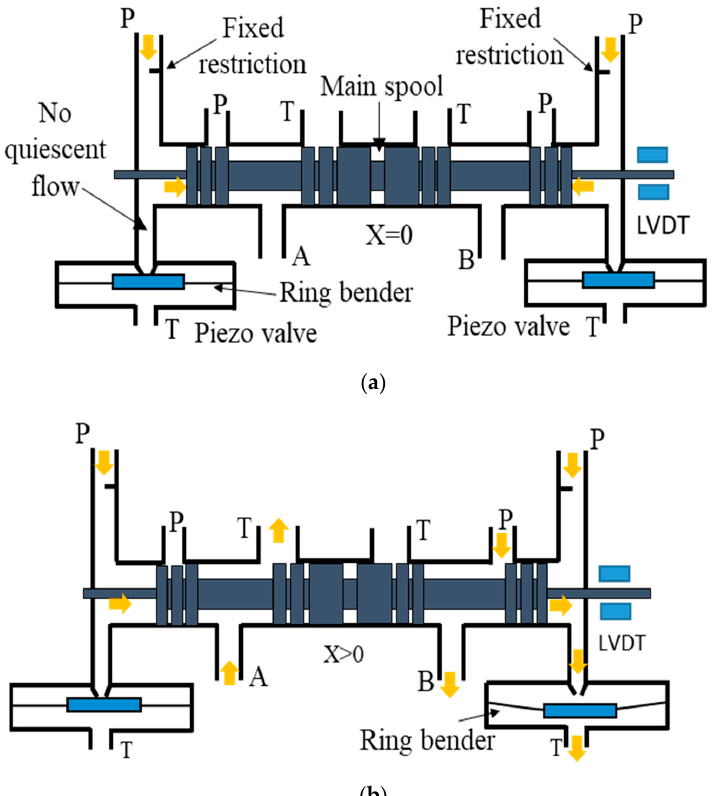
Figure 2. Operating principle of the novel servovalve actuated by two ring benders: spool not modulating flow ( a ) and flow modulation ( b ).